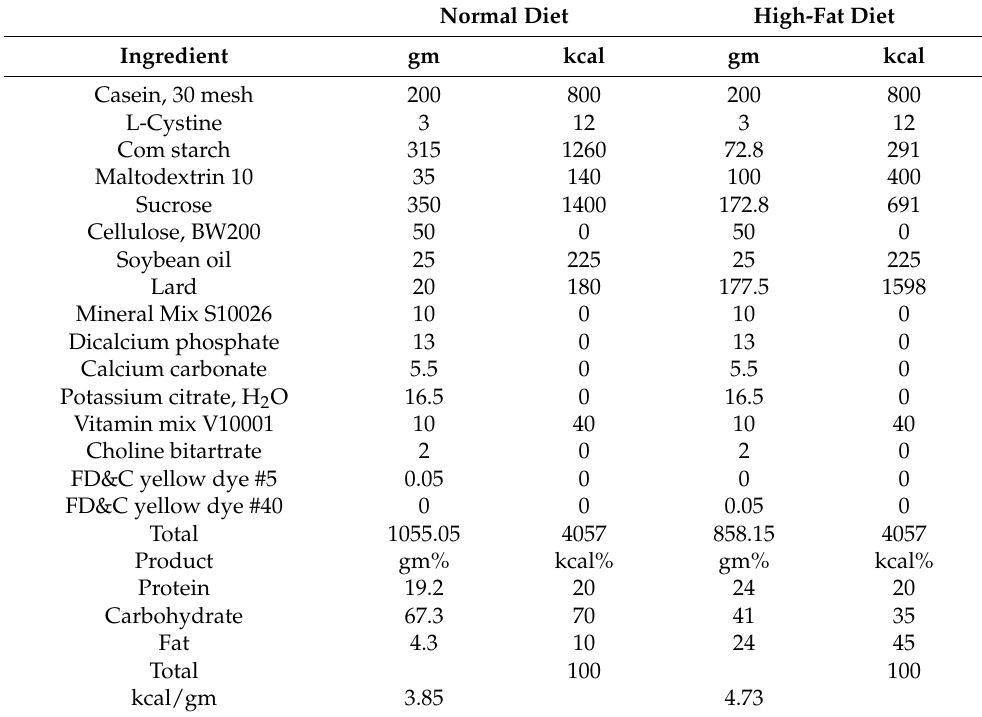
Table 1. The composition of a normal diet and high-fat diet.